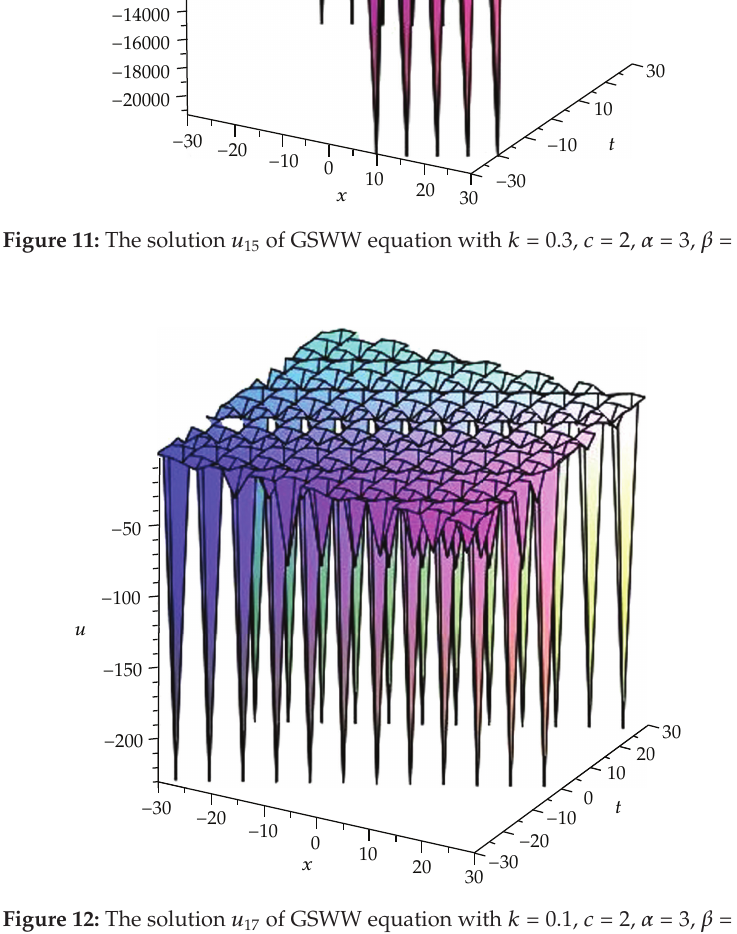
Figure 12: The solution u 17 of GSWW equation with k (cid:7) 0 . 1, c (cid:7) 2, α (cid:7) 3, β (cid:7)